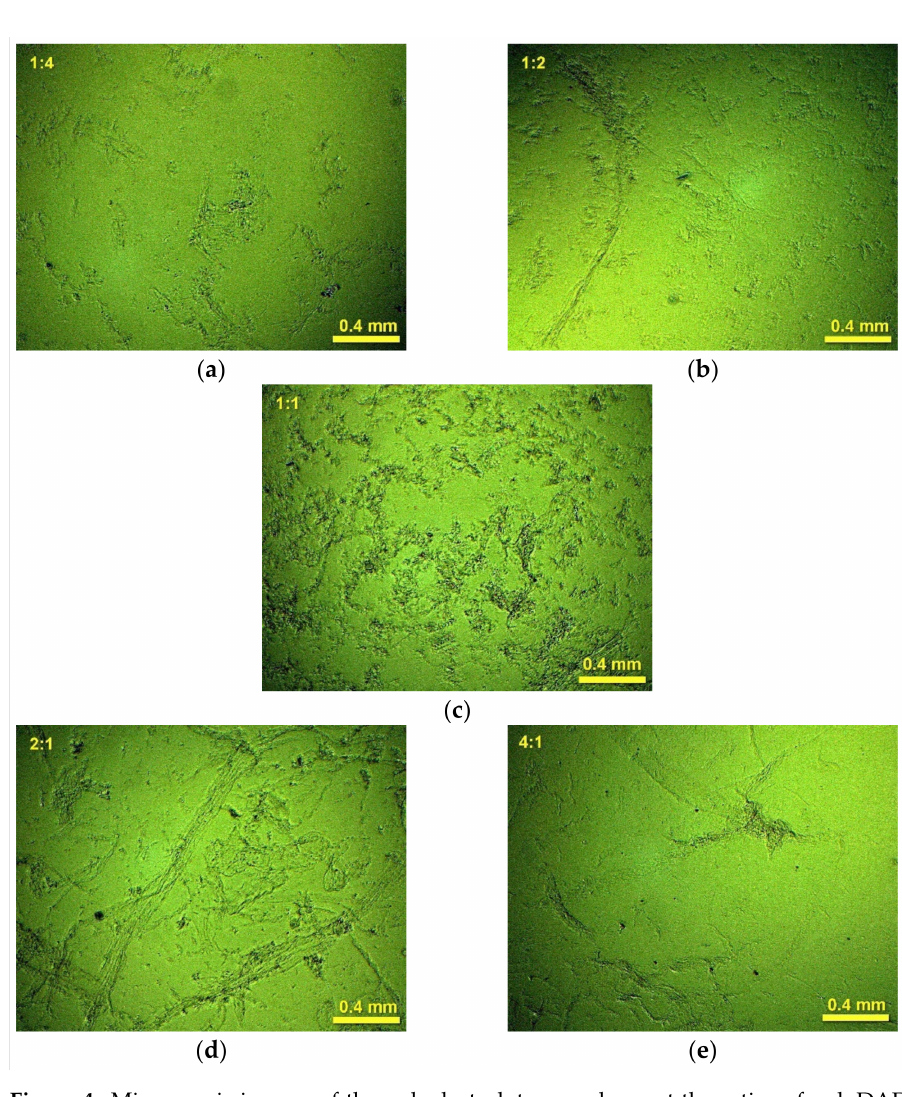
Figure 4. Microscopic images of the polyelectrolyte complexes at the ratios of polyDADMAC to